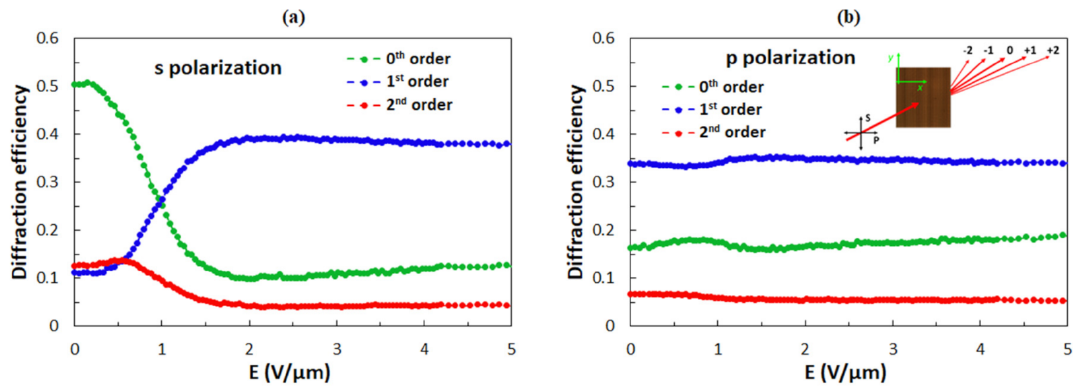
Figure 4. Experimentally determined diffraction efficiencies of the 0th, 1st, and 2nd diffraction orders as a function of the amplitude of the applied external electric field E for ( a ) s-polarized and ( b ) p-polarized incident beams. The inset in ( b ) is a schematic drawing of the diffraction experiment, in which the linearly polarized laser beam enters the sample at normal incidence with respect to the grating structure. The s- and p-polarization directions and assignment of different diffraction orders are also